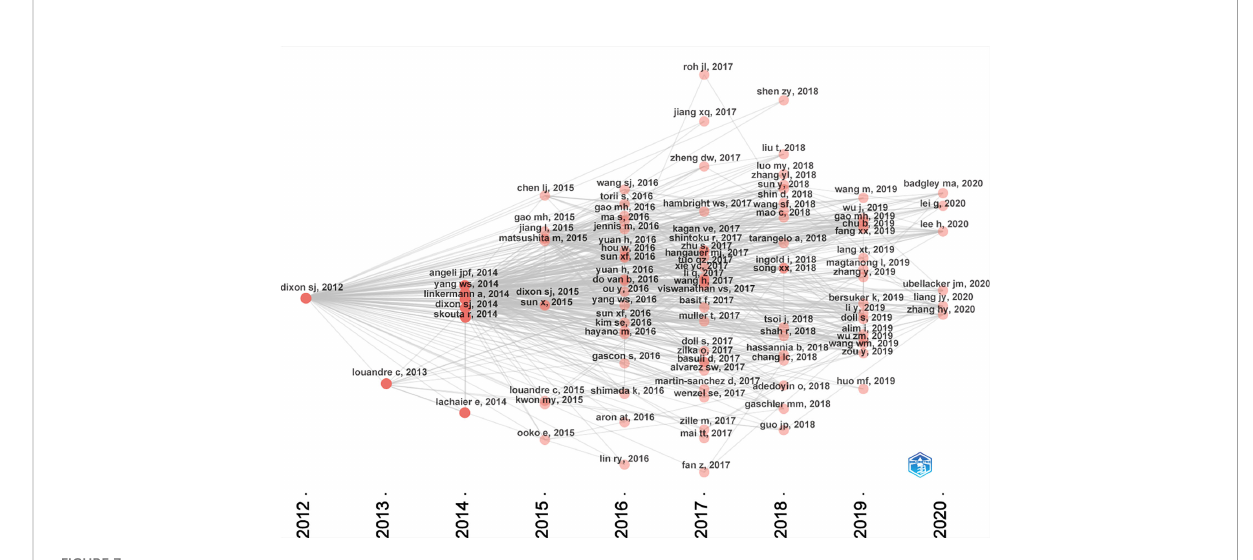
FIGURE 7 Historical direct citation network map of the top 100 articles.